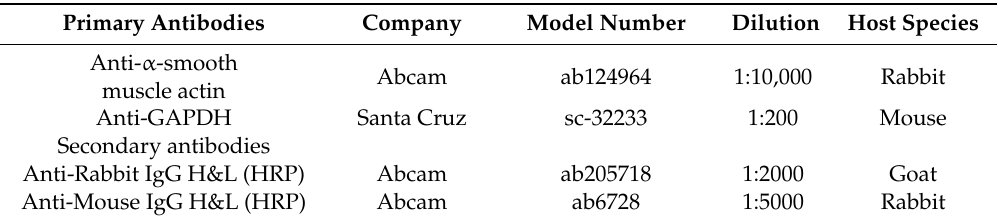
Table 2. List of antibodies used in Western